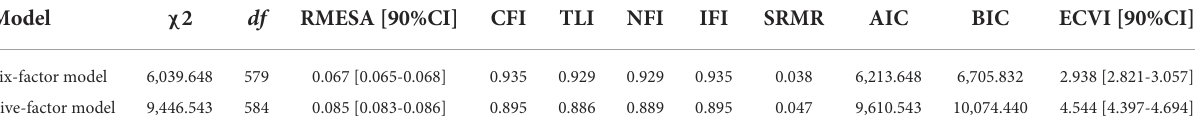
TABLE 2 Fit indices of various structural models for confirmatory factor analysis ( n = 2,116). Model χ 2 df RMESA [90%CI] CFI TLI NFI IFI SRMR AIC BIC ECVI [90%CI]